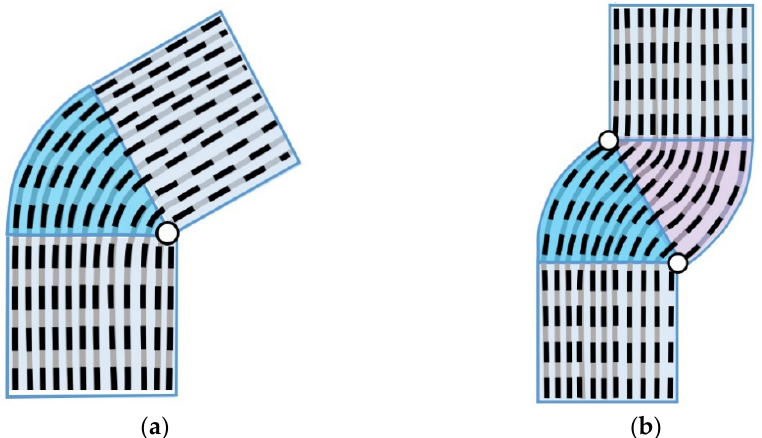
Figure 12. In these highly stylized sketches, the broken lines indicate columns of molecules in an M phase structure. The lines have been drawn in this fashion to make the lateral positioning clear. Note the way in which a pairing of domains maintains the long-range register between the columns. In Figure ( a ), the columns are drawn in register at the bottom of the figure and slide out of phase as they curve through the wedge of the developable domain. In Figure ( b ), the addition of an apposed domain cancels the effect of the first and brings the columns back into register. Note that the long stripes of the developable domain structure shown in Figure 10 contain a balanced pairing of seg- ments.